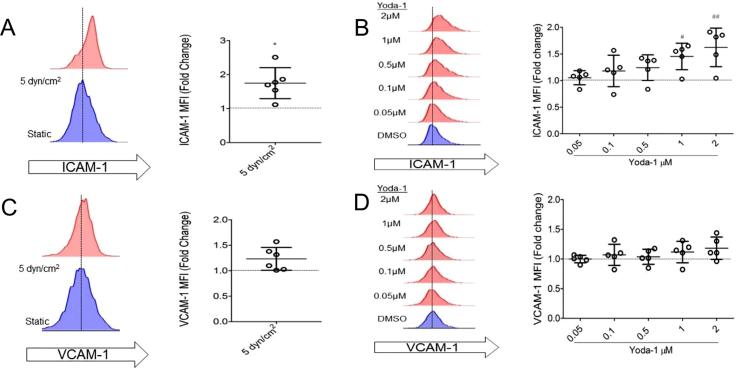
Yoda-1 treated endothelium mimic phenotypes observed in endothelium under laminar shear stress. (A–D) HUVEC were cultured under laminar flow with a constant shear stress of 5 dyn/cm2, or under static conditions using a concentration range of Yoda-1, for 24 h. ICAM-1 (A-B) or VCAM-1 (C–D) surface levels were detected by flow cytometry. Representative histograms from a single experiment are shown, followed by median fluorescence intensity (MFI) normalised to their appropriate static culture control. Each circular point represents one independent experimental repeat recorded on a different day. (A, C) Two-tailed non-parametric test conducted. *P < 0.01. (B, D) One-way ANOVA with Dunnett’s post test conducted. ##P < 0.001 ###P < 0.001.